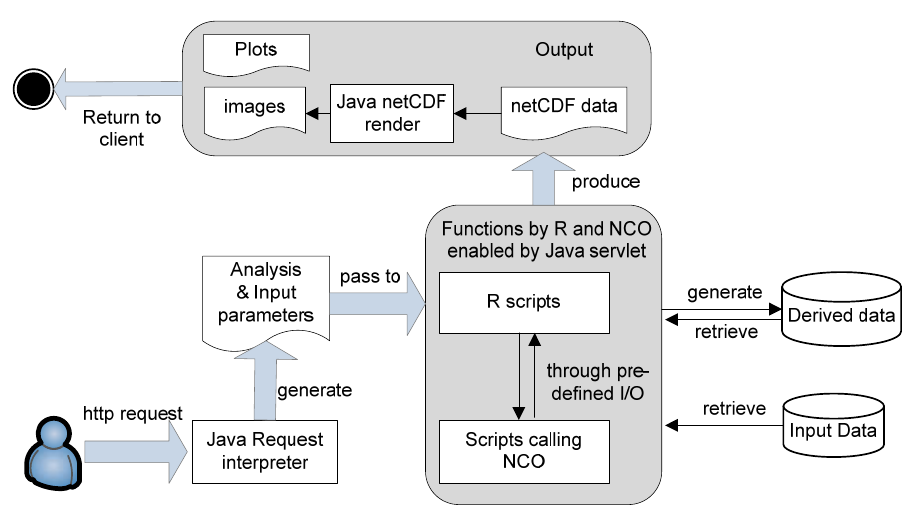
Figure 4. Workflow of the application